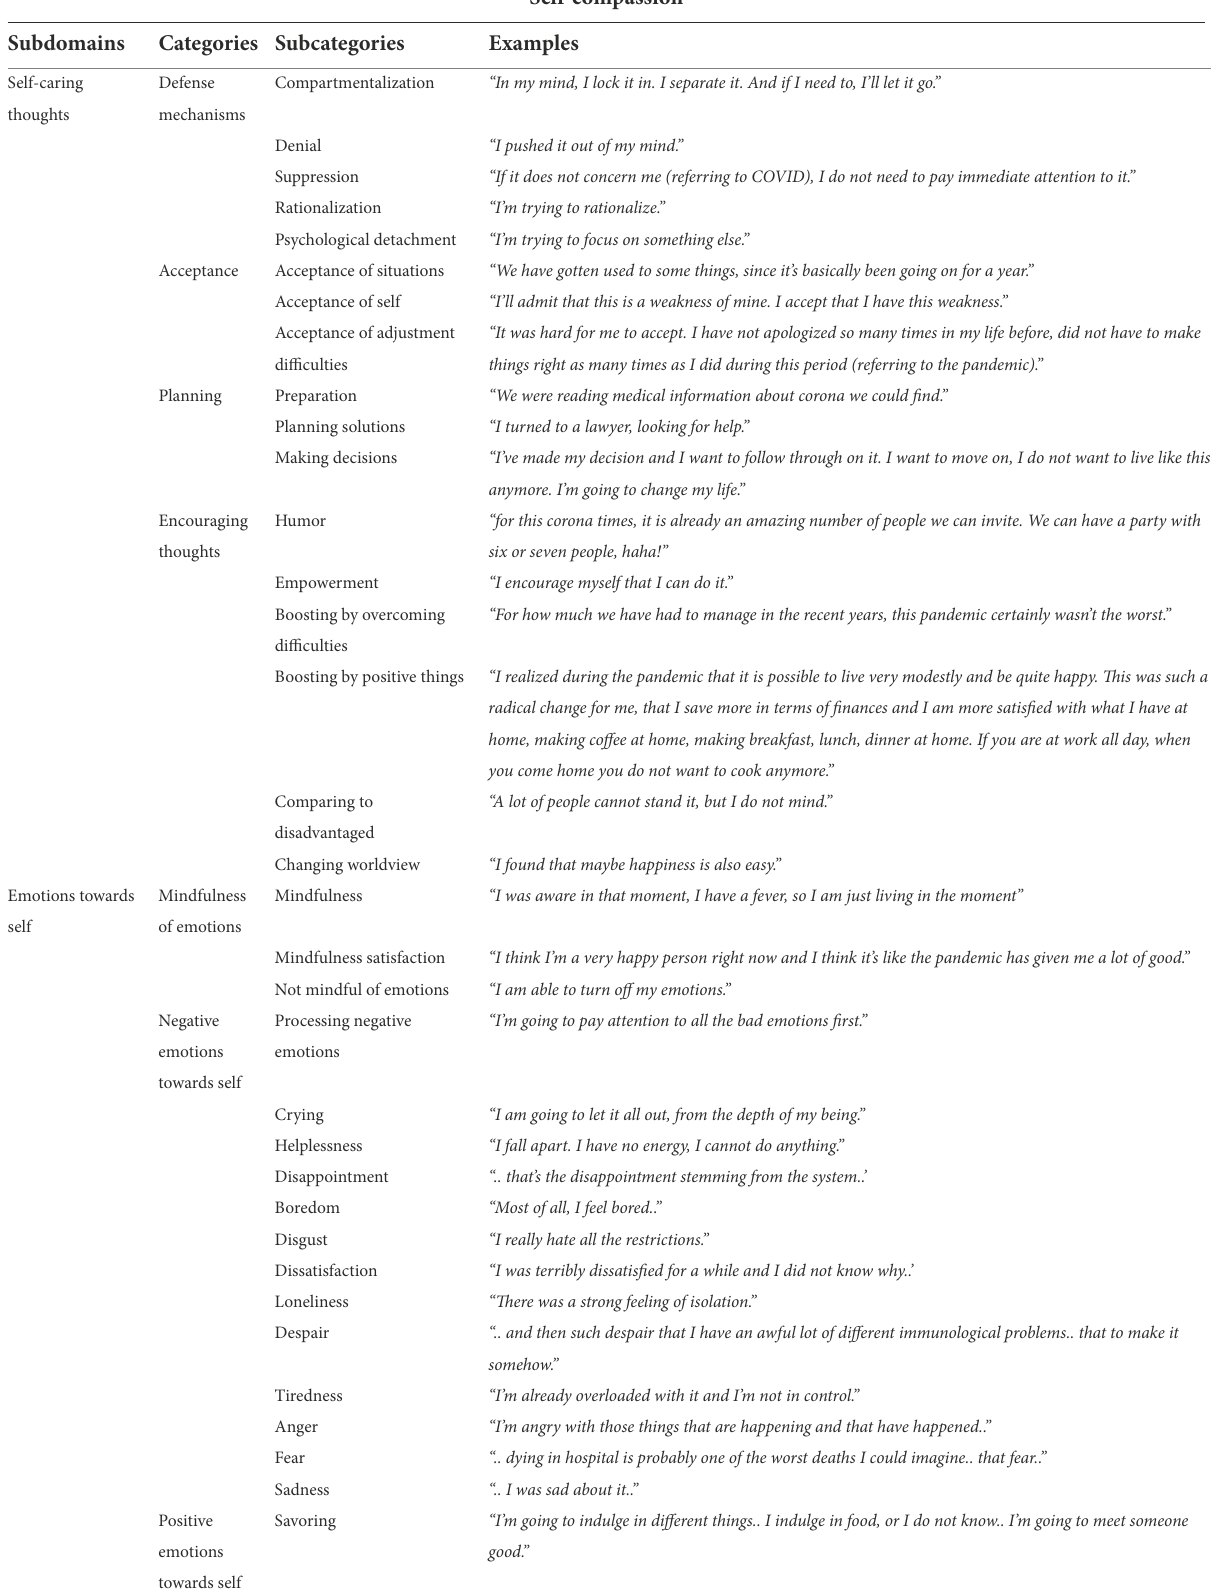
Self-compassion